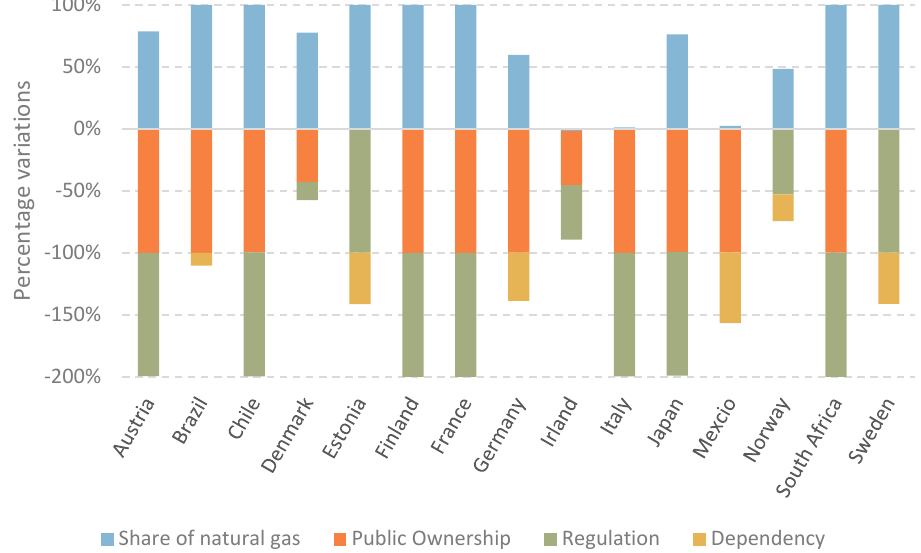
Figure 5. Modifications for reaching the frontier—natural gas market. Source: The authors.